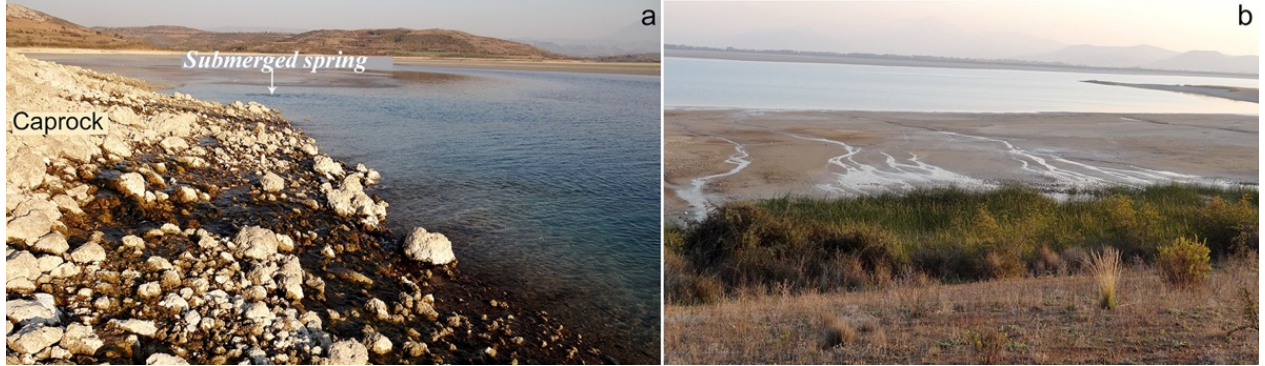
Figure 5. Gypsum springs in Thana artificial lake: ( a ) big linear springs; ( b ) small linear springs; ( c ) submerged springs.